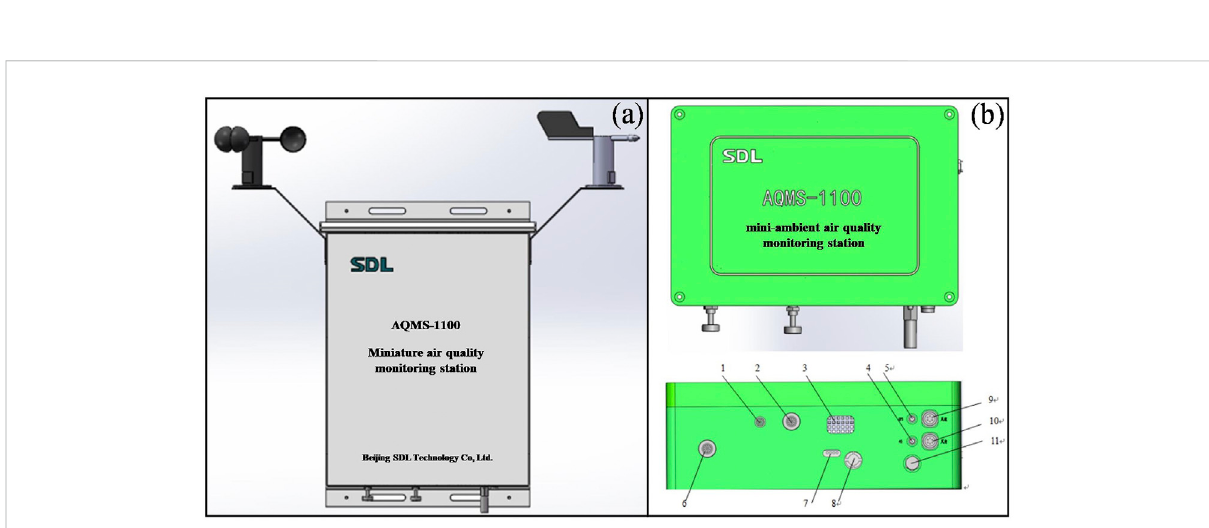
FIGURE 1 Layout of the study area demonstrating locations of the sampling sites (chemicals industry: , Textile dyeing industry: , Pharmaceuticals industry: , Metal smelting industry: , Leather industry: , Residential area: ) (from Google Maps).